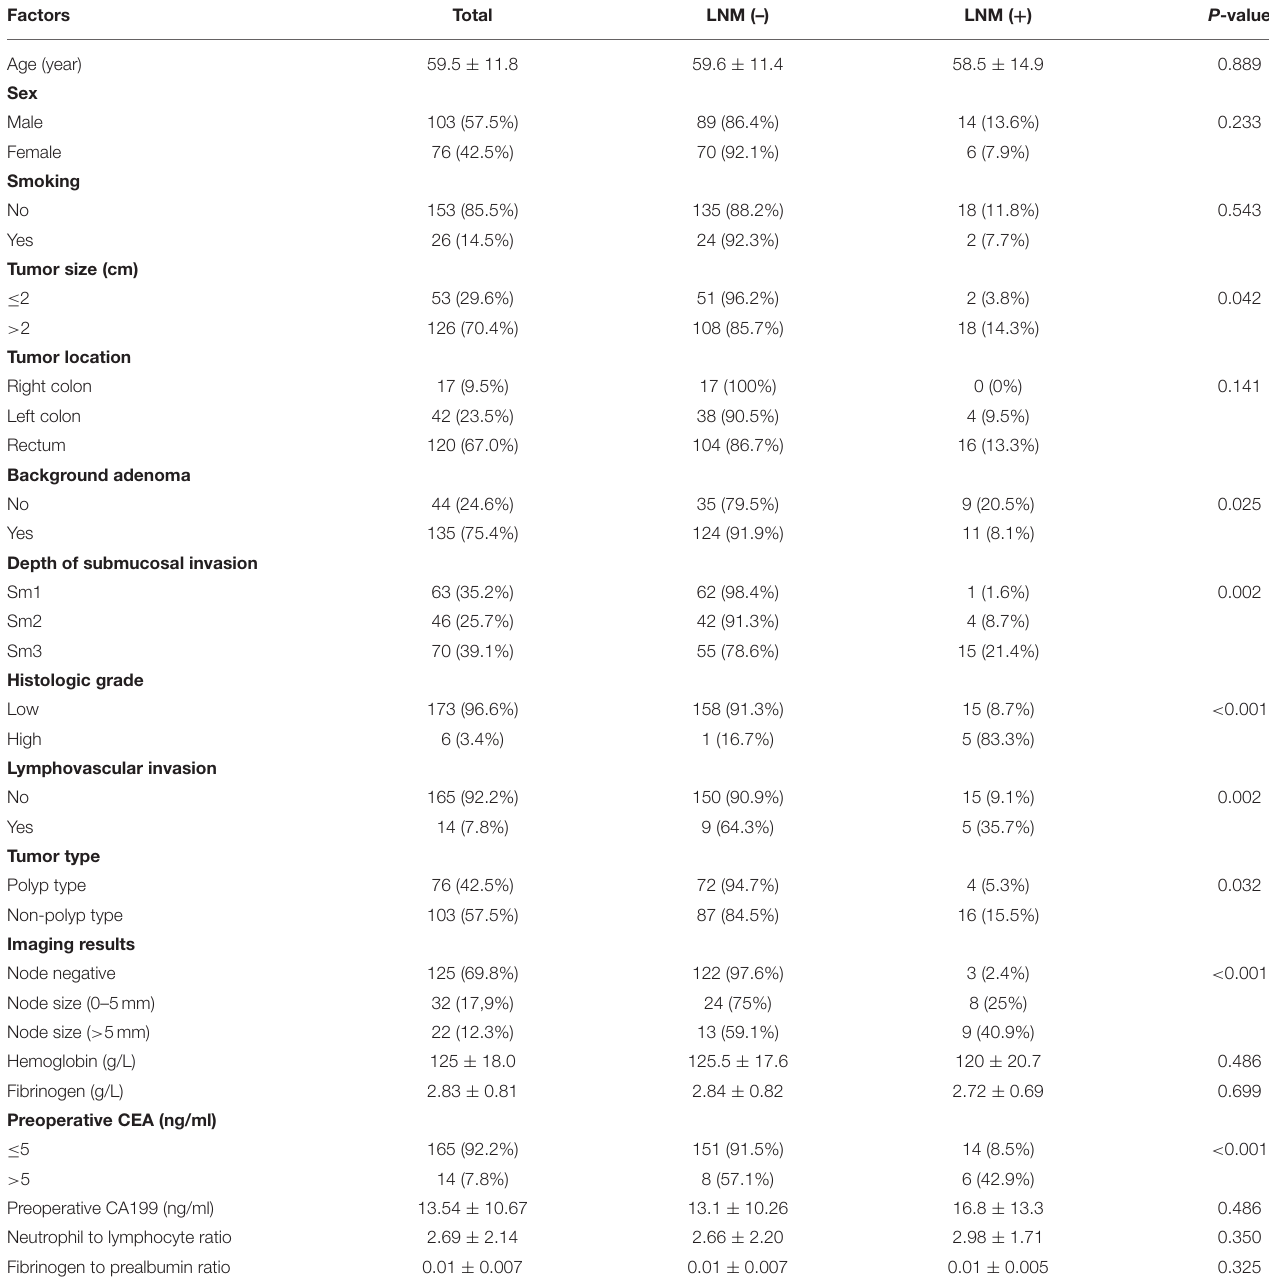
TABLE 1 | Clinicopathological and imaging features of patients with stage T1 colorectal cancer.